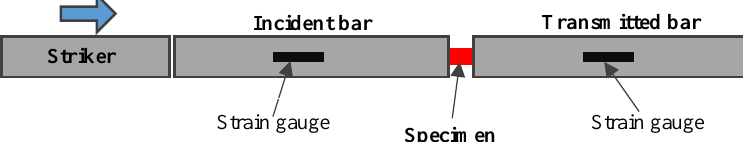
Fig. 2. The schematic diagram and components for the Split Hopkinson Pressure Bar used for dynamic tests.